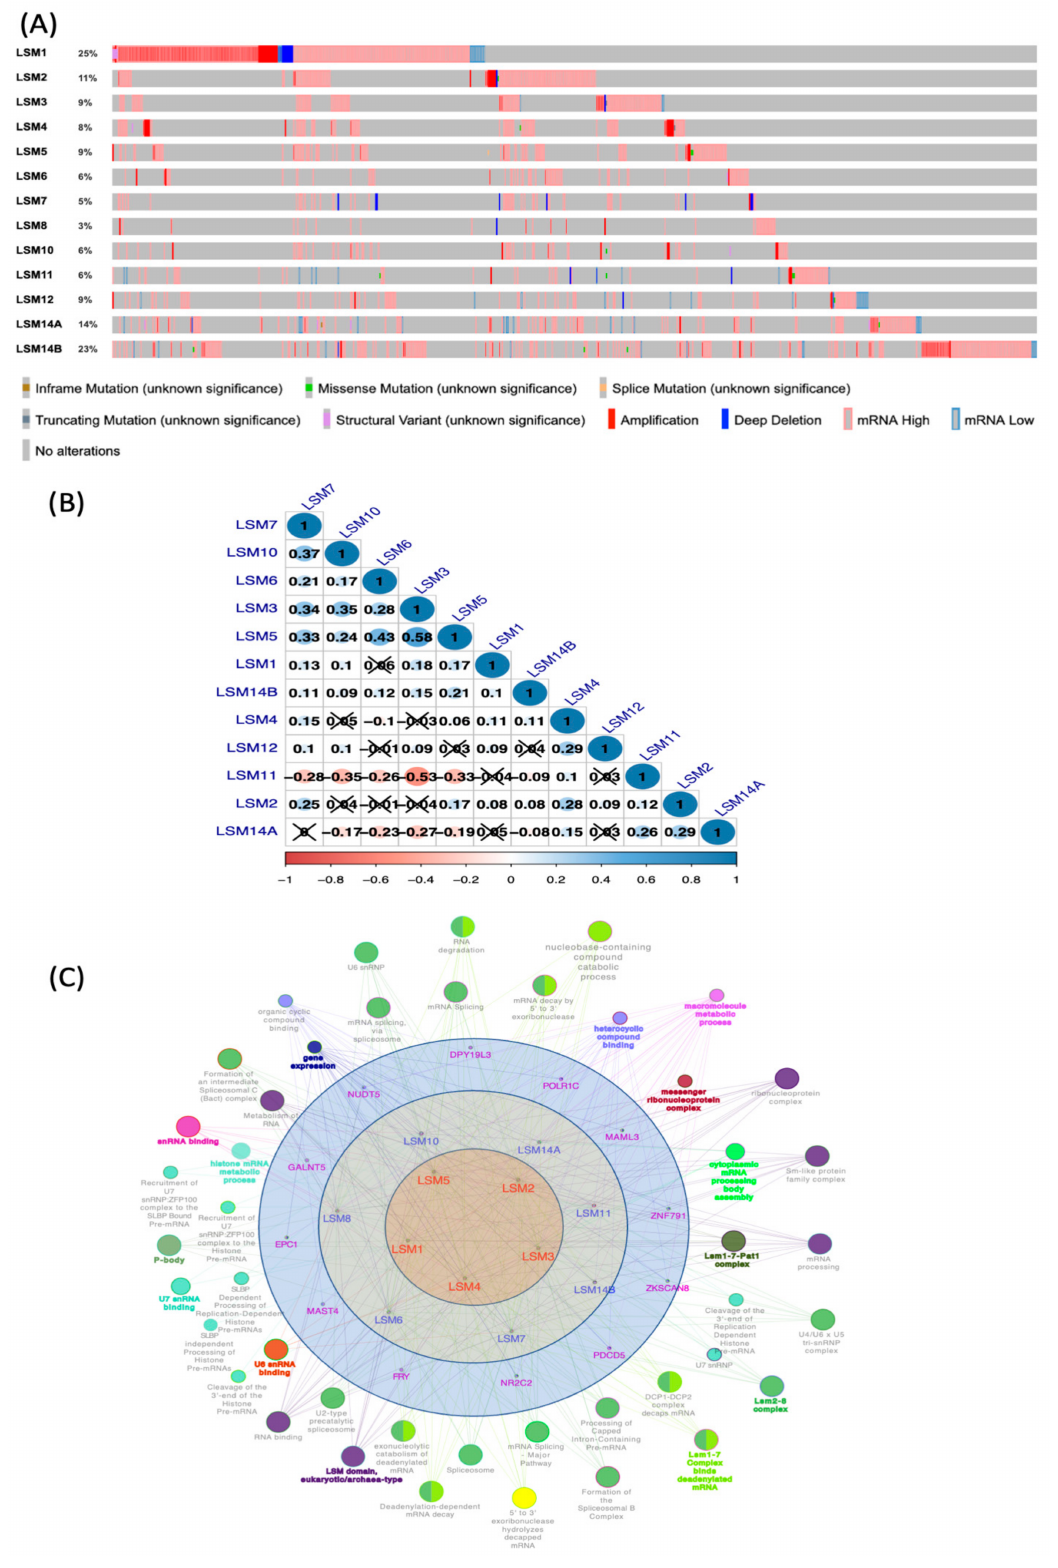
Figure 2. Genetic alterations in LSMs (cBioportal) and co-expression analysis (Cytoscape). ( A ) Summary of alterations in LSMs in TCGA PanCancer Atlas ( n = 1082). The red bars show gene amplification, blue bars stand for deep deletions,